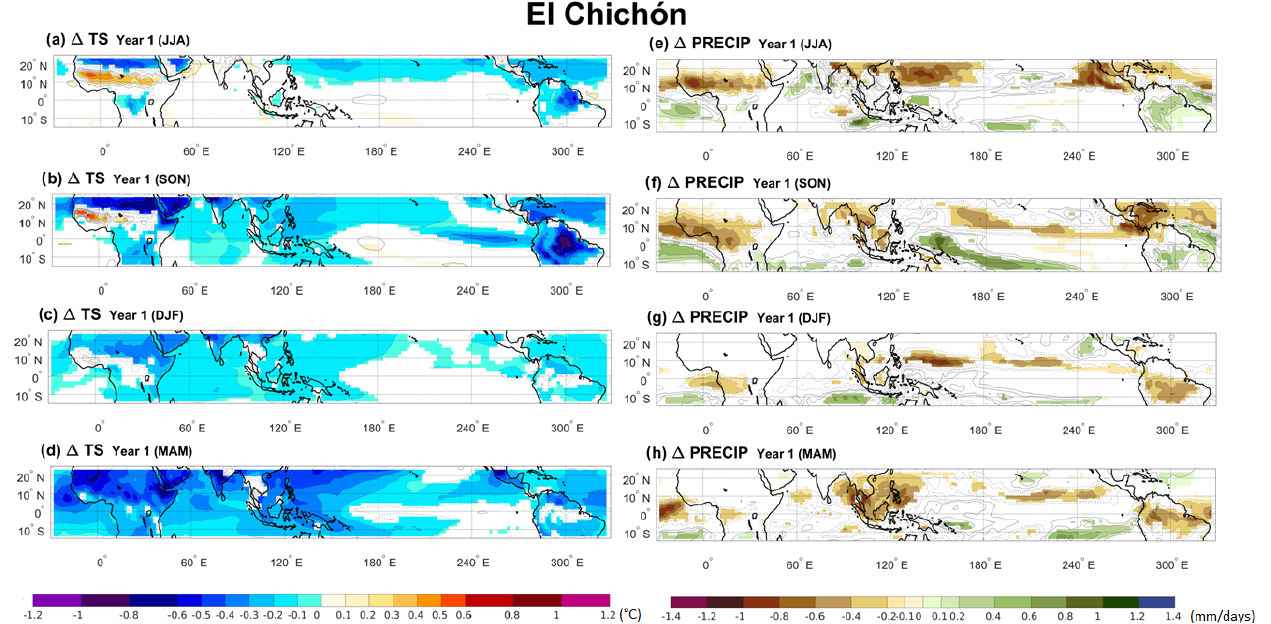
Figure A4. Ensemble mean of changes in surface temperature (a, b, c, d) and precipitation (e, f, g, h) between the climatology and the volcano case for each season of the year after the El Chichón eruption. Only significant anomalies are shown with an approximate 95% confidence level using Student’s t test. Contours show temperature and precipitation anomalies following the colour bar scale (solid line for positive anomalies and dashed line for negative